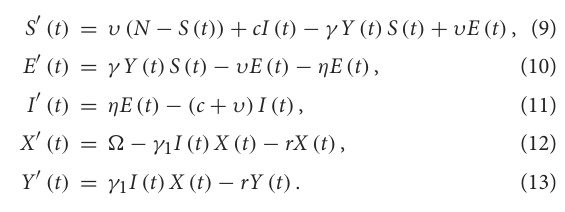
There are two delays in virus transmission via a